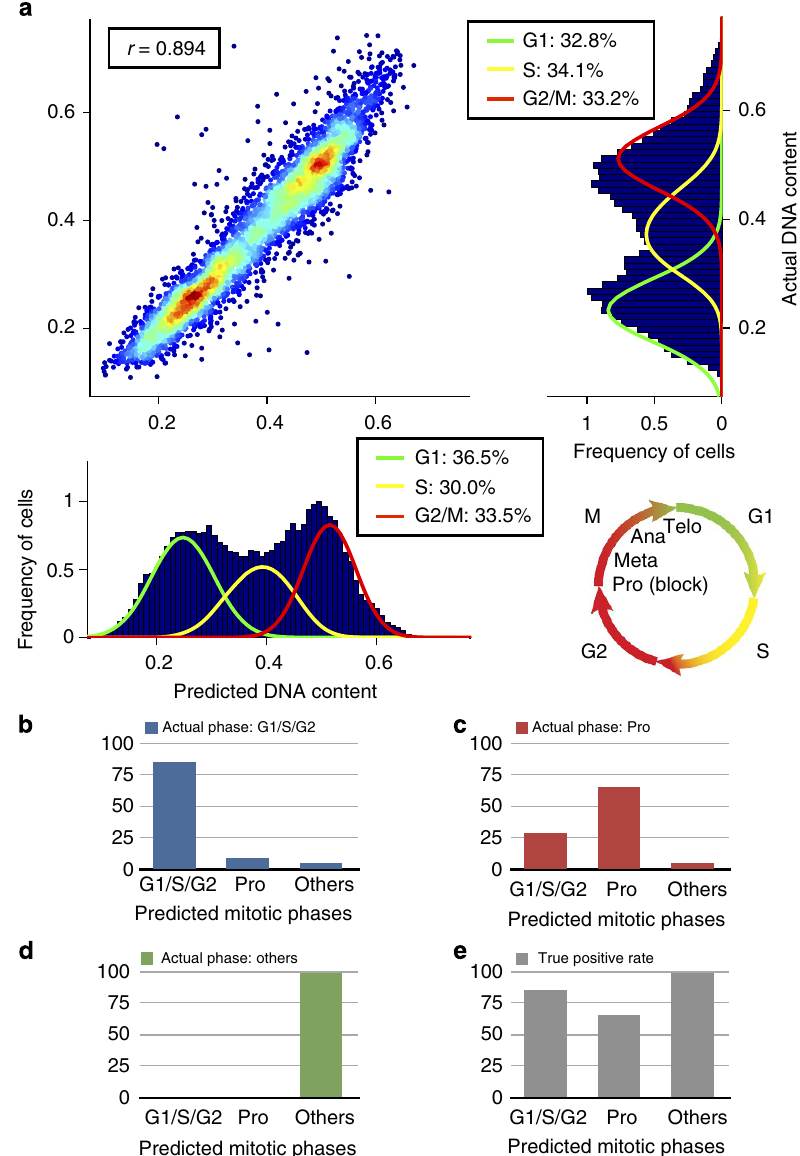
Figure 3 | Label-free prediction of DNA content and cell cycle phases for fixed Jurkat cells treated with a prophase blocking agent. ( a ) Based only on brightfield and darkfield features, we find a Pearson’s correlation of r ¼ 0.894 ± 0.032 (error bars indicate the s.d. obtained via 10-fold cross-validation) between actual DNA content and predicted DNA content using regression (see Methods section). We applied the Watson pragmatic algorithm to determine the G1, S and G2/M phases in the DNA histograms. ( b – d ) For cells that are actually in a particular phase (for example, b shows cells in G1/S/G2), the bar plots show the classification results (see Methods section) (for example, b shows that the few cells in prophase (Pro) and the other mitotic phases (others) are errors). Note that we grouped the cells in metaphase, anaphase and telophase into one class since we only detected very little cells in those phases after treatment with the prophase blocking agent. ( e ) Bar plot of the true positive rates of the cell cycle classification. Using boosting with random undersampling to compensate for class imbalances, we obtain true positive rates of 65.5 ± 6.3% (P), 85.8 ± 1.4% (G1/S/G2) and 100%